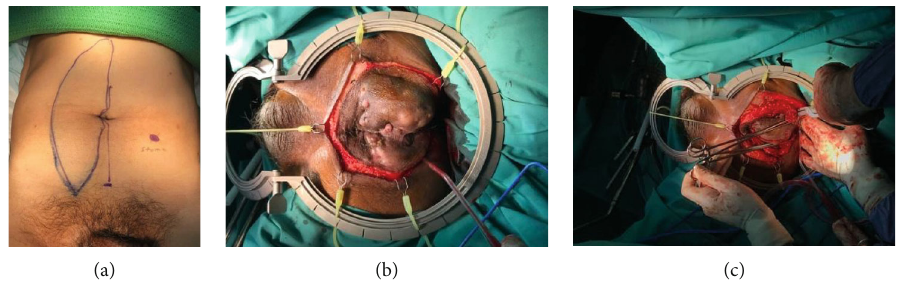
Figure 2: (a – c) Preoperative marking of VRAM fl ap and en bloc resection.